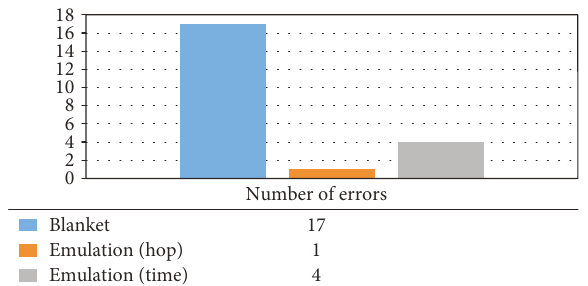
Figure 19: Comparison of the number of found errors and